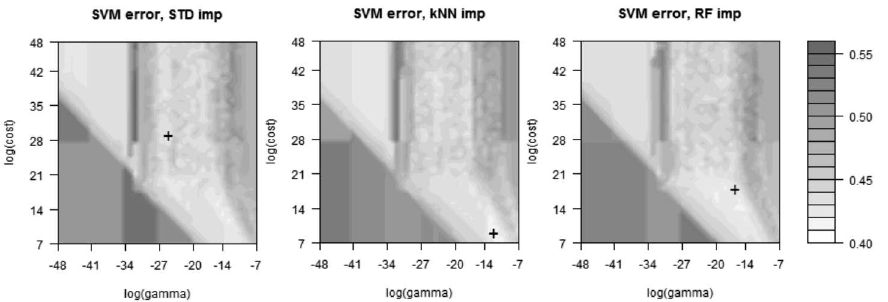
Figure 5. Results for SVM classifier – second parameter set